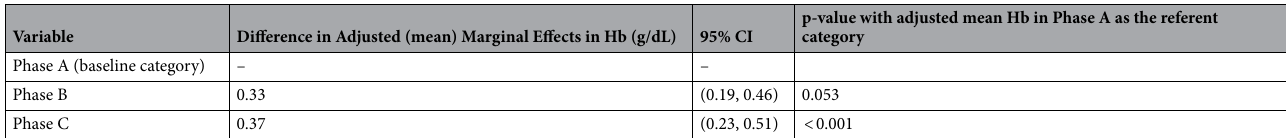
Table 3. Adjusted Mean Marginal Effects from the Mixed-effects regression model with predictors: Phase, month, phase-month interaction, TSAT, Ferritin, TIBC, total administered iron (Venofer + Triferic), and